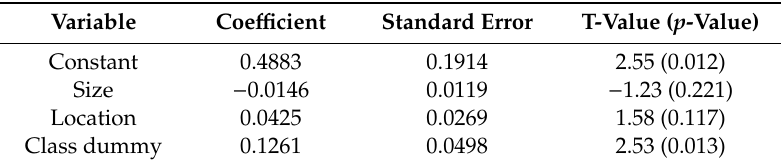
Table 9. Results of Tobit regression for firm ine ffi